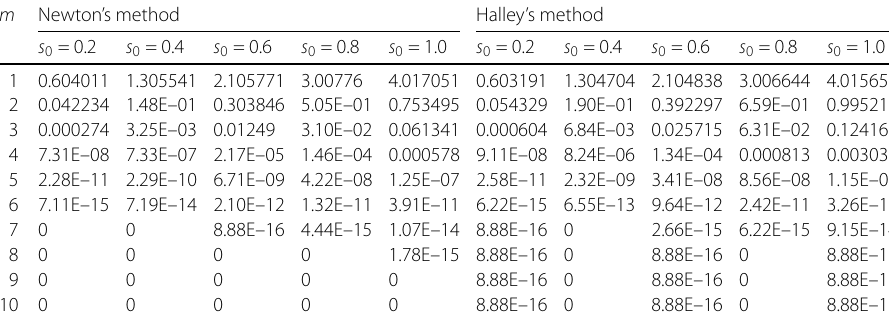
Table 1 Errors of shooting techniques |˜ F ( s m ) | in (41) versus the maximum number of iterations with various values of s 0 in Example 4.1. We set h = 0.01, α 1 = 0.4, α 2 = 1.7 m Newton’s method Halley’s method s 0 =